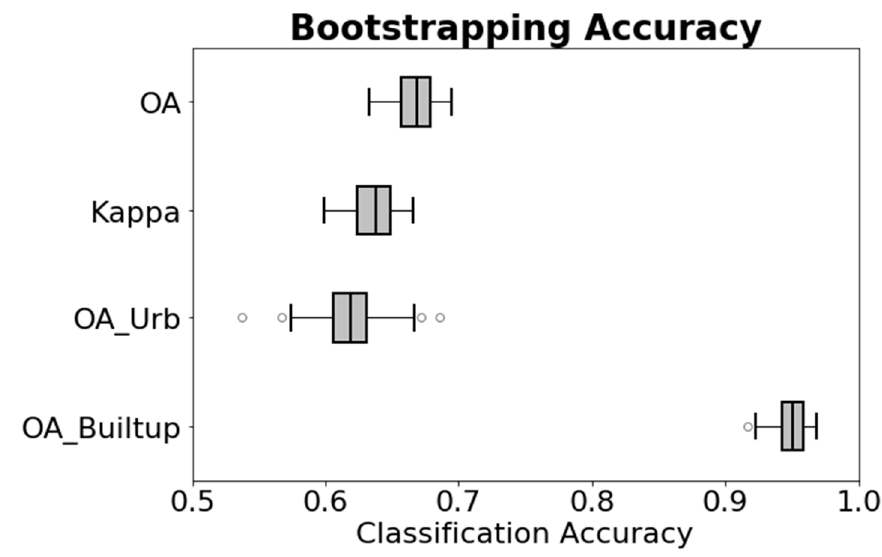
Figure A1. Examples of spatial patterns of different LCZs from high-resolution reference data.